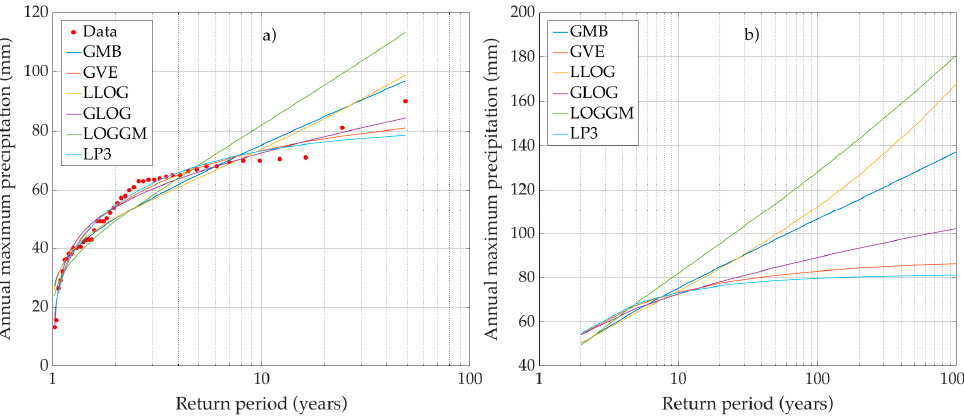
Figure 5. Frequency analysis of maximum yearly precipitation recorded at the station 11035: ( a ) fitted distributions; and ( b ) estimated quantiles.